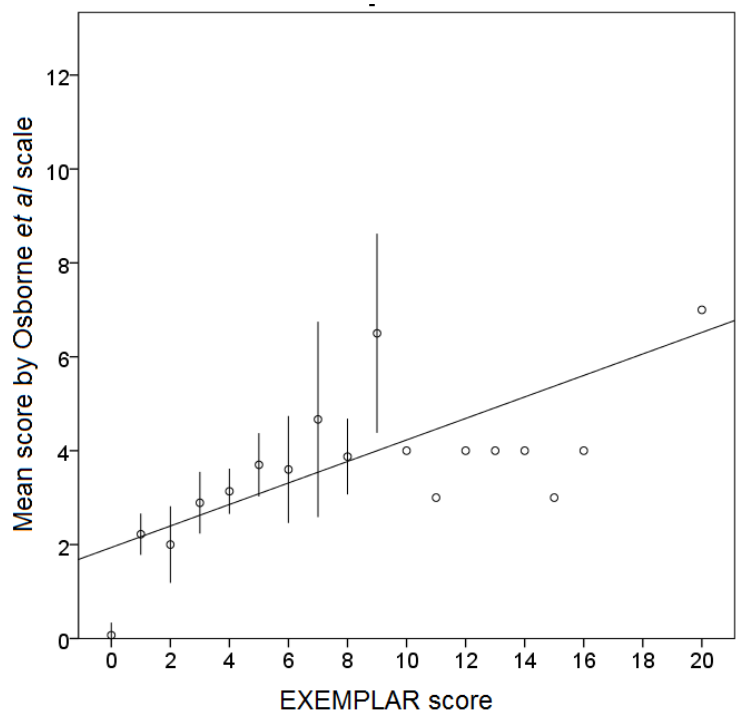
Figure 5. The mean “Osborne score” for journals with the same EXEMPLAR classification, with an overlaid best-fit regression line (R 2 = 0.39). Error bars represent ± 1 standard deviation of the mean for “Osborne score”, for a confidence interval of 95%. No journal was classified with an EXEMPLAR score of 17, 18 or 19 points. Correlation was stronger (Pearson’s r = 0.736), for lower scoring journals (under 10 points in the EXEMPLAR scale, corresponding to 91% of the sample).